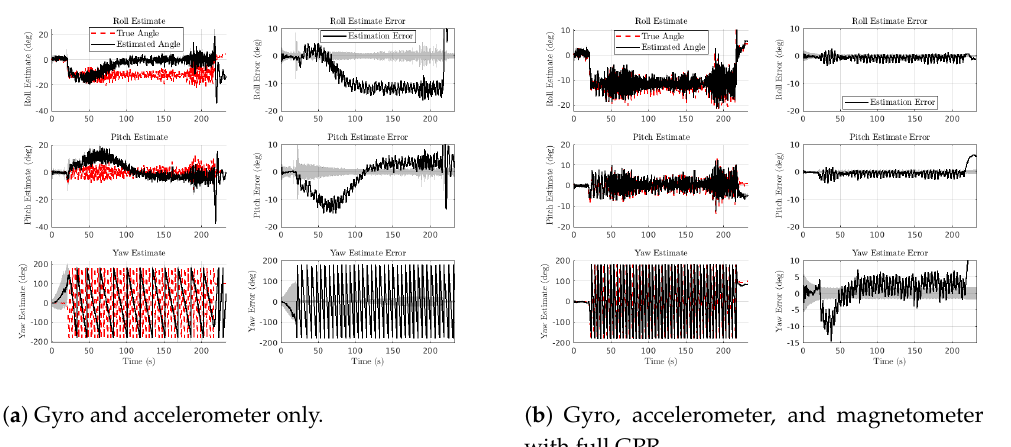
Figure 11. Time series plots for roll, pitch, and yaw estimates of test_117 (fast level circle). Linear and centripetal accelerations caused pitch and roll errors (respectively) in Figure 11a that were corrected with the magnetometer in Figure